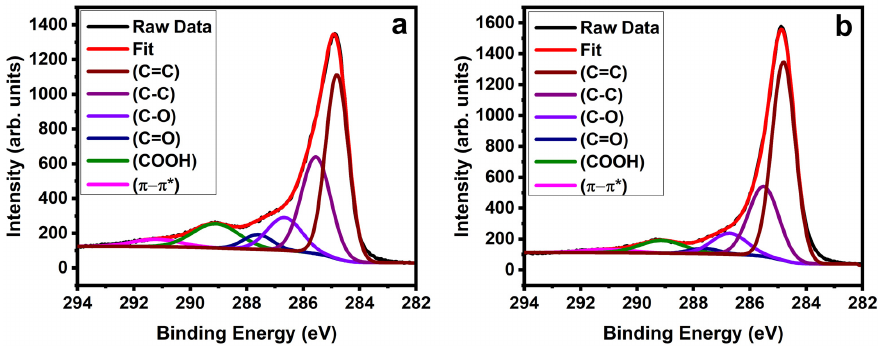
Figure 2. XPS of the carbon C 1s peak of carboxylated SWNTs (a) before and (b) after